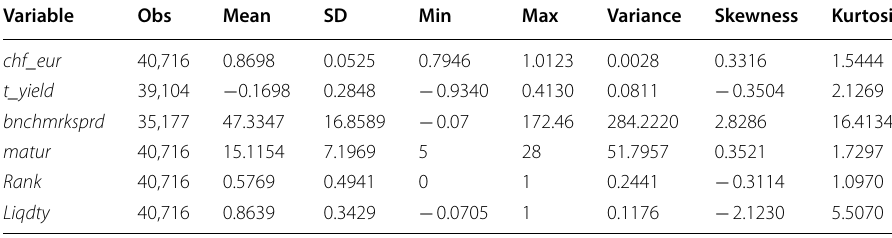
Table 1 Summary descriptive statistics all